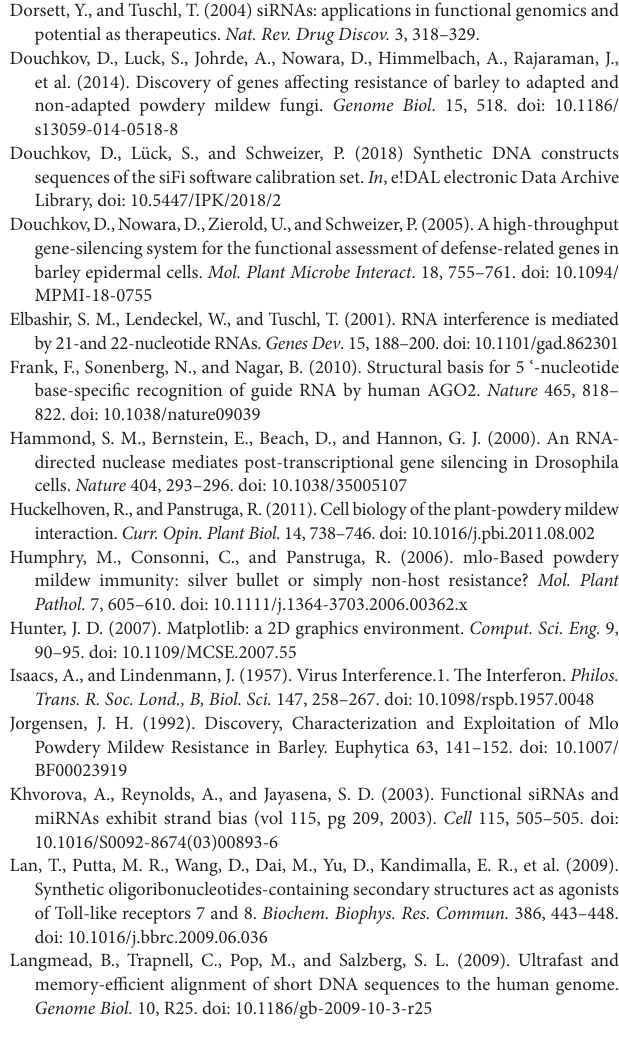
SUPPLEMENTARY TABLE S1| Comparison of prediction and experimentaly validated regions for RNAi efficience SUPPLEMENTARY TABLE S2| Experimental results of the TIGS experiments. In total 15 independent experiments were conducted, where each of the